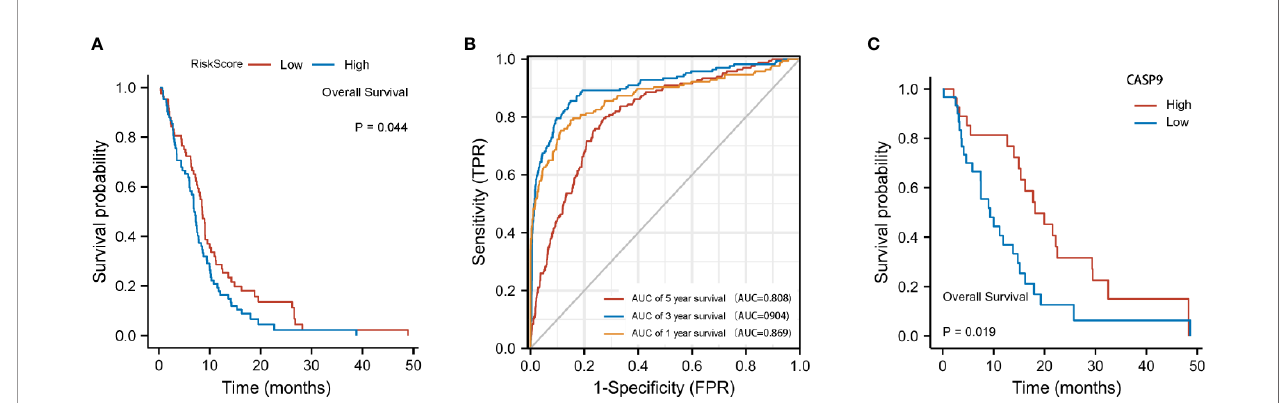
FIGURE 3 | Validation of the three-gene signature in the validation cohort. (A) Kaplan – Meier curves for the OS of patients in the high-risk group and low-risk group in the validation cohort. (B) AUC of time-dependent ROC curves veri fi ed the prognostic performance of the risk score in the validation cohort. (C) Patients with a low CASP9 expression level exhibited a poor prognosis.